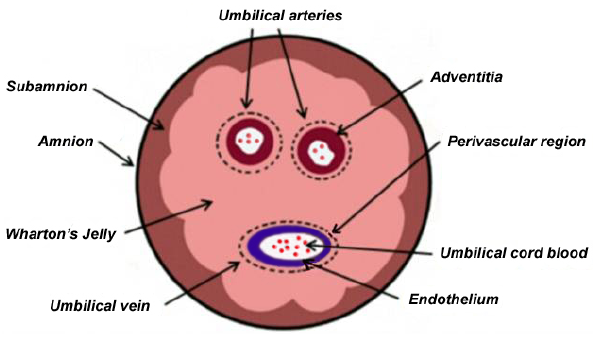
Figure 1. Cross-sectional diagram of human umbilical cord shows anatomical compartments, including Wharton’s jelly, as a source of stem